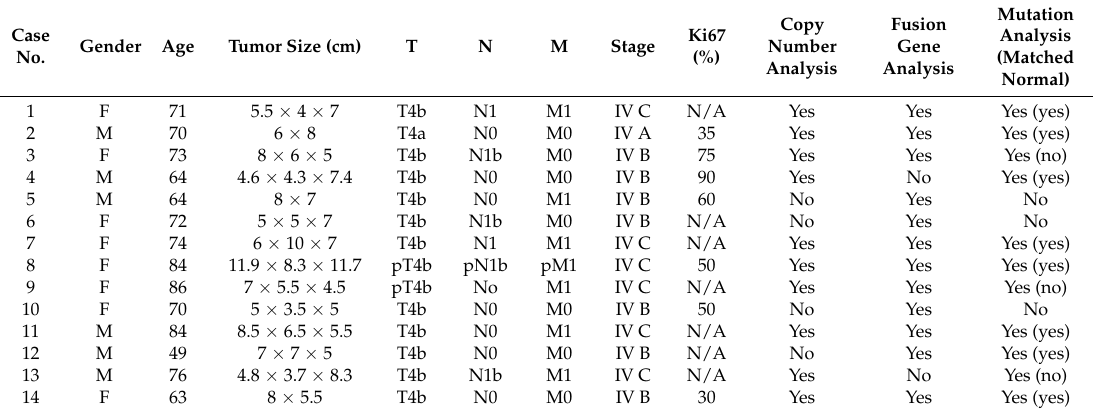
Table 1. Clinical data and genetic analyses of 14 cases of primary anaplastic thyroid cancer.